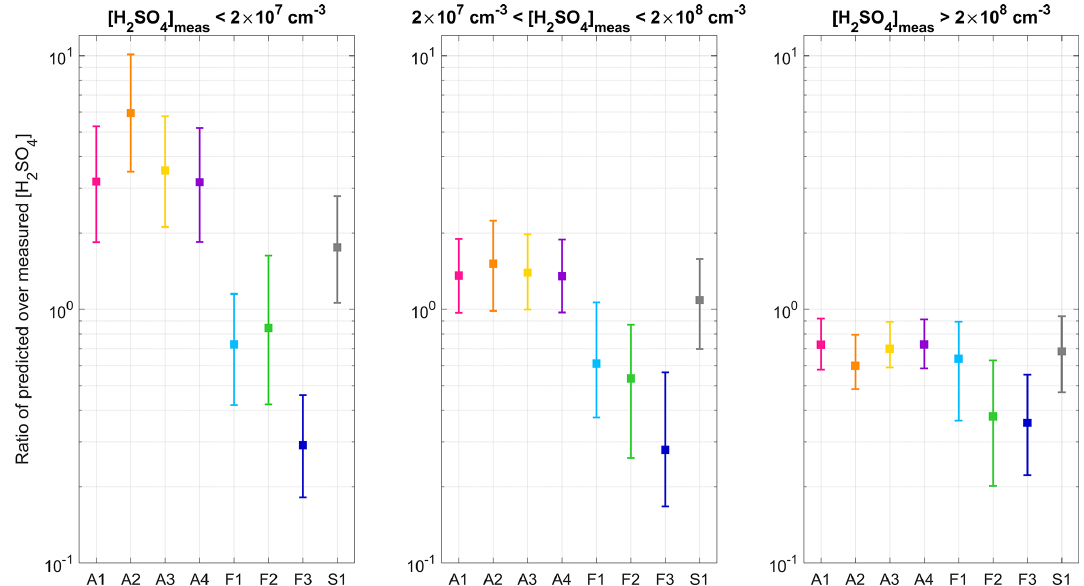
Figure 5. Ratio between predicted and measured [H 2 SO 4 ] in the different [H 2 SO 4 ] subranges. For each proxy, the marker represents the median of the ratio, and the lower and upper limits of the error bars indicate the 25th and 75th percentiles